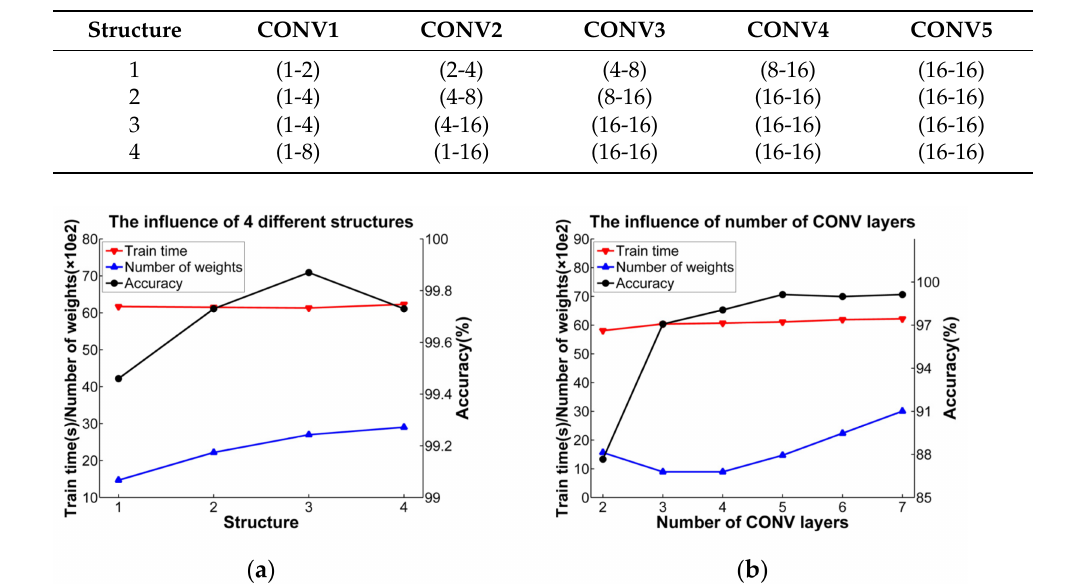
Table 2. Different structures of CNN models.